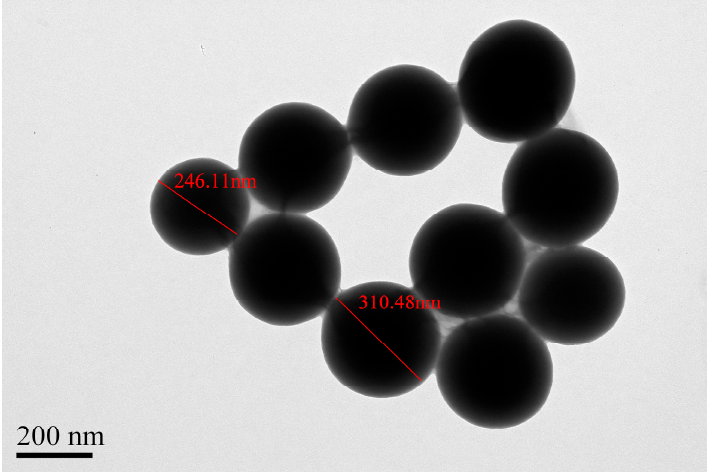
Figure 4. Silica nanoparticles observed by TEM.